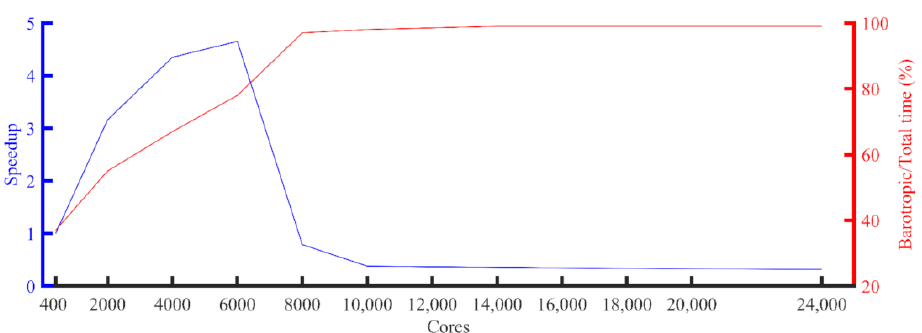
Figure 1. Speedup of the 5-km Nucleus for European Modelling of the Ocean (NEMO) experiment using the preconditioned conjugate gradient (PCG) solver (blue line) and the percentage of the barotropic time of the total execution time (red line). The baseline of the speedup is the running time corresponding to 400